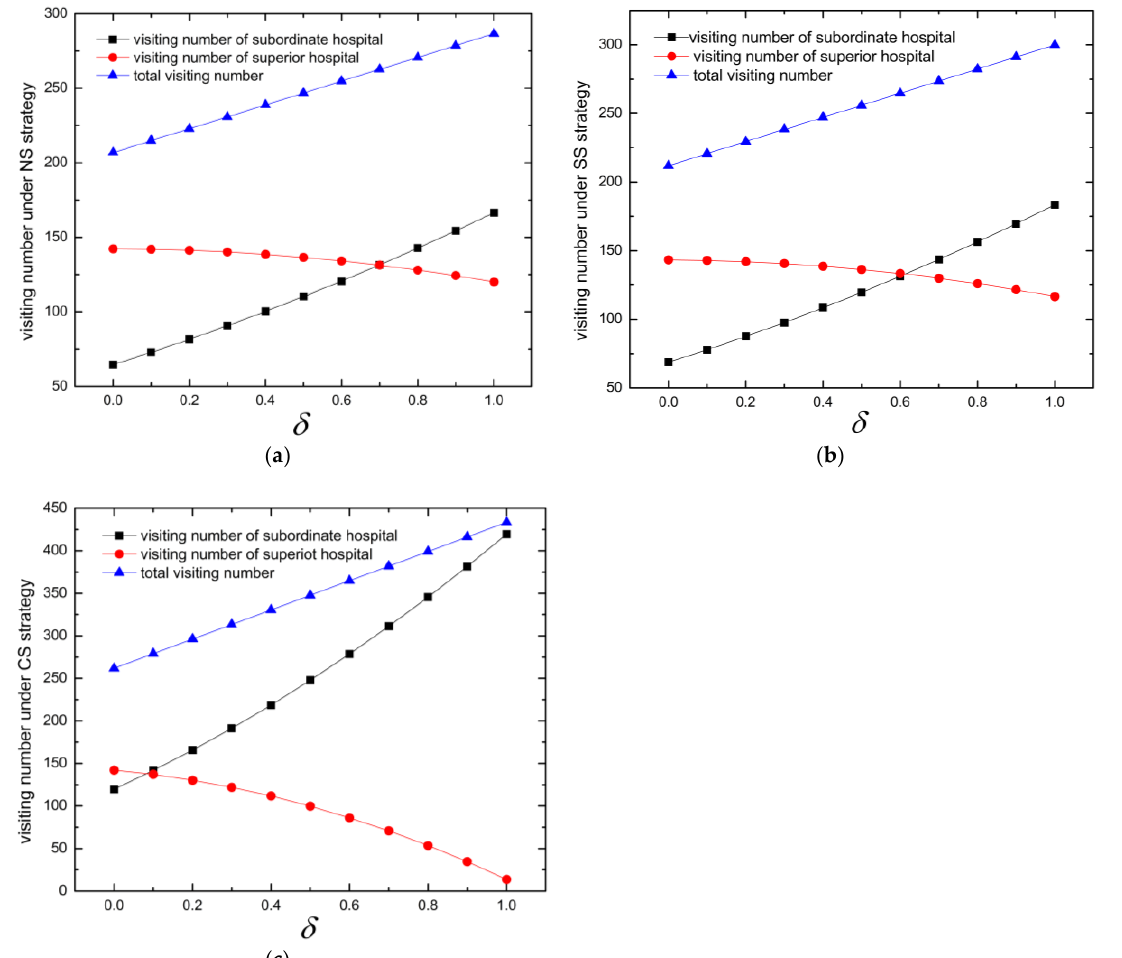
Figure 3. Number of visitors with reference price effects under different strategies: ( a ) Nash strategy (NS); ( b ) Stackelberg strategy (SS); ( c ) Centralized strategy (CS).